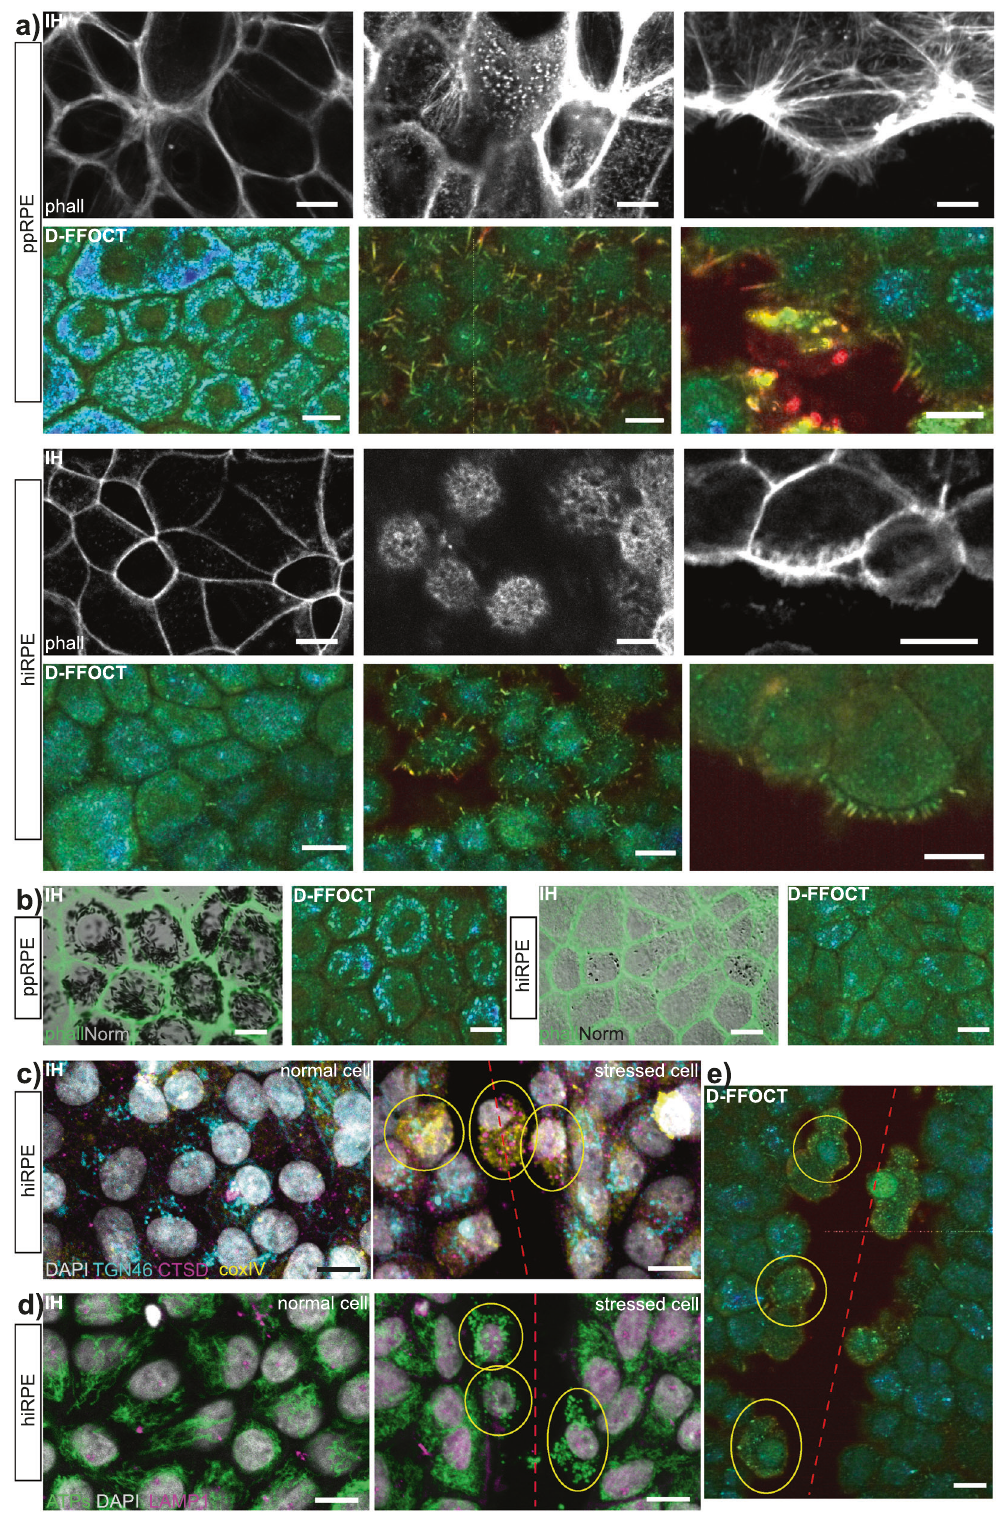
healthy individual mitochondria (diameter 0.4 μ m) were not resolved but gave a general background signal, while the bright dots in stressed cells suggest that they are damaged mitochondria which formed larger spheres that could be individually distinguished 24,25 . This behaviour disappears a few days after the scratch assays (Supplementary Fig. 5b): cells on the border of the wound no longer appear bright and the dynamic pro fi le of the